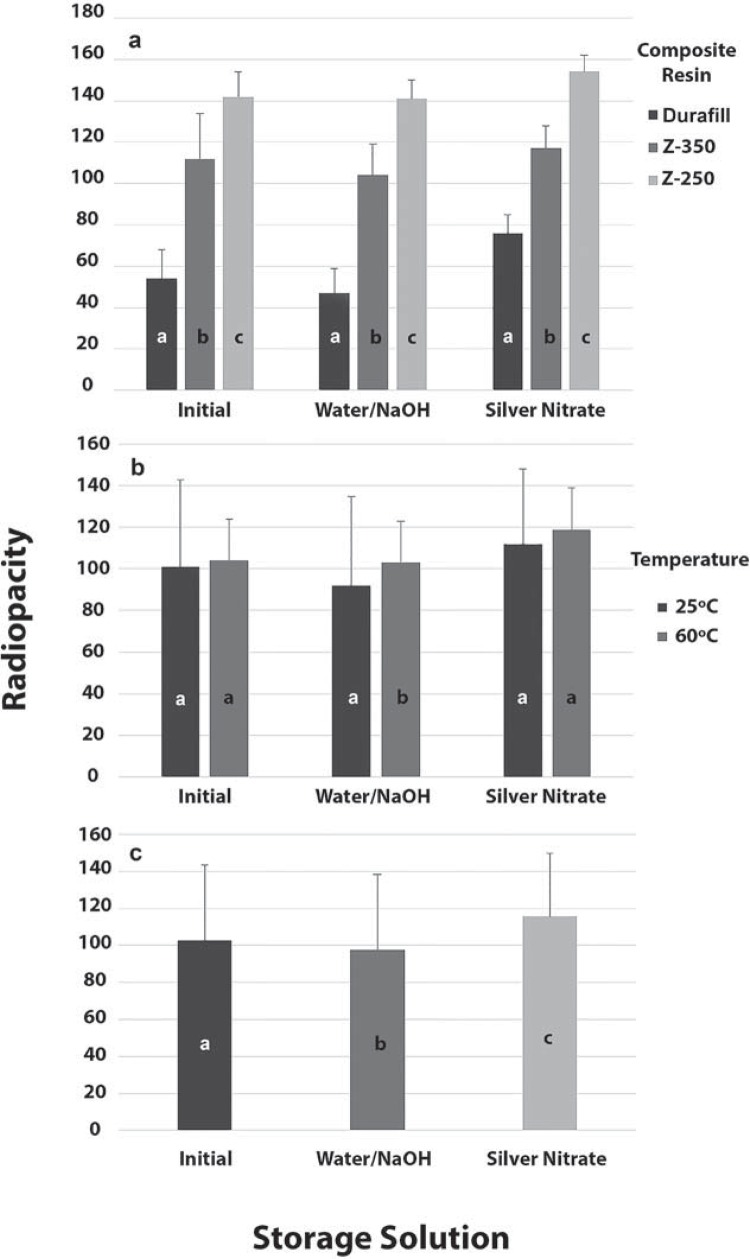
Mean radiopacity values obtained for the three composite resins assessed a) according to storage solution (Tukey’s test); b) according to curing temperature and storage solution (ANOVA); and c) according to storage solution only (Tukey’s test for paired data). Different letters indicate statistically significant differences (p<0.05)